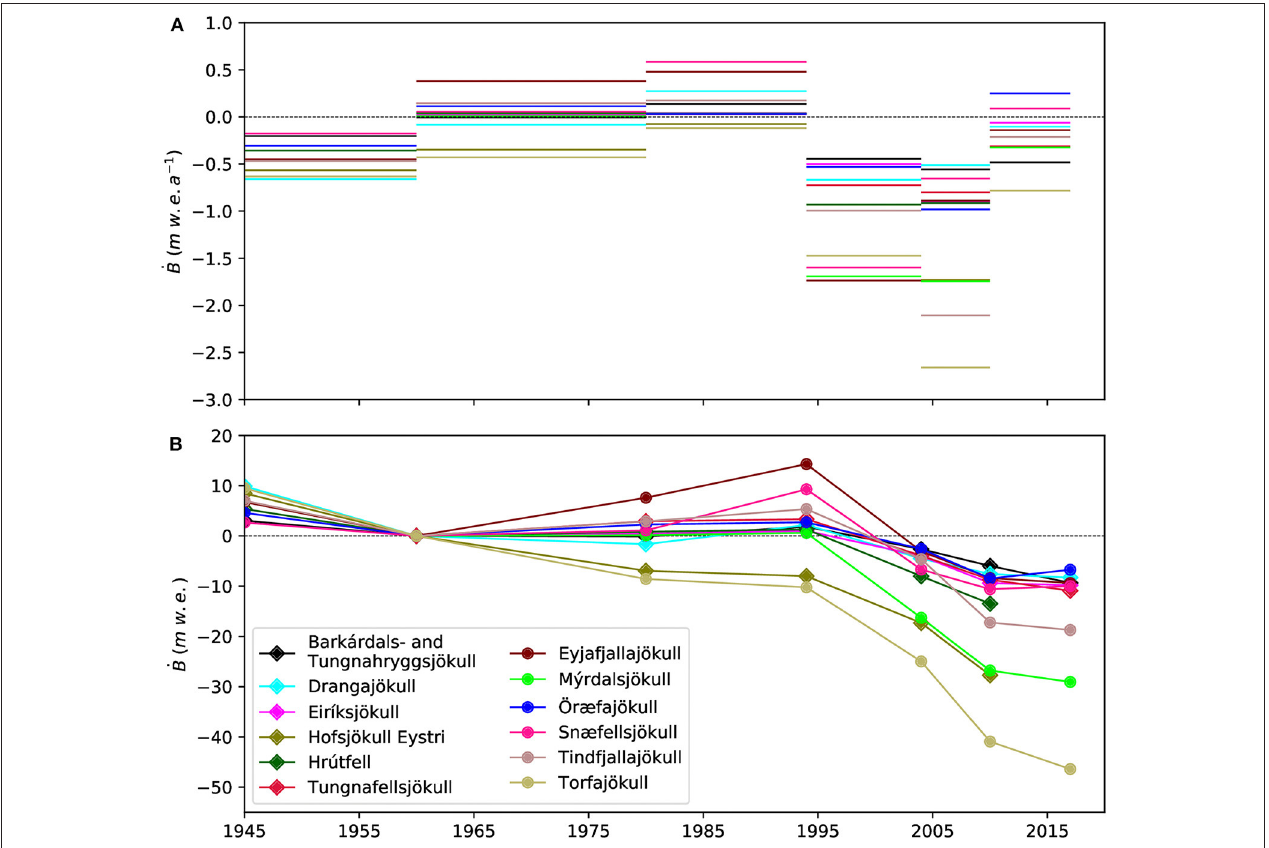
FIGURE 5 | (A) Average mass balance after temporal homogenization during the six time periods. (B) Cumulative mass balance centered on 1960 (common year for the selected glaciers). Diamonds indicate glaciers located in the interior, North and East of Iceland and circles glaciers on South and West Iceland.